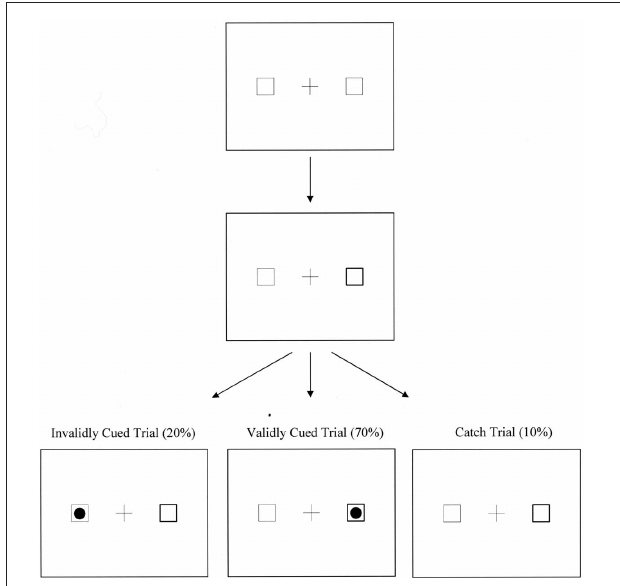
FIGURE 1 | The sequence of events within a trial in Experiments